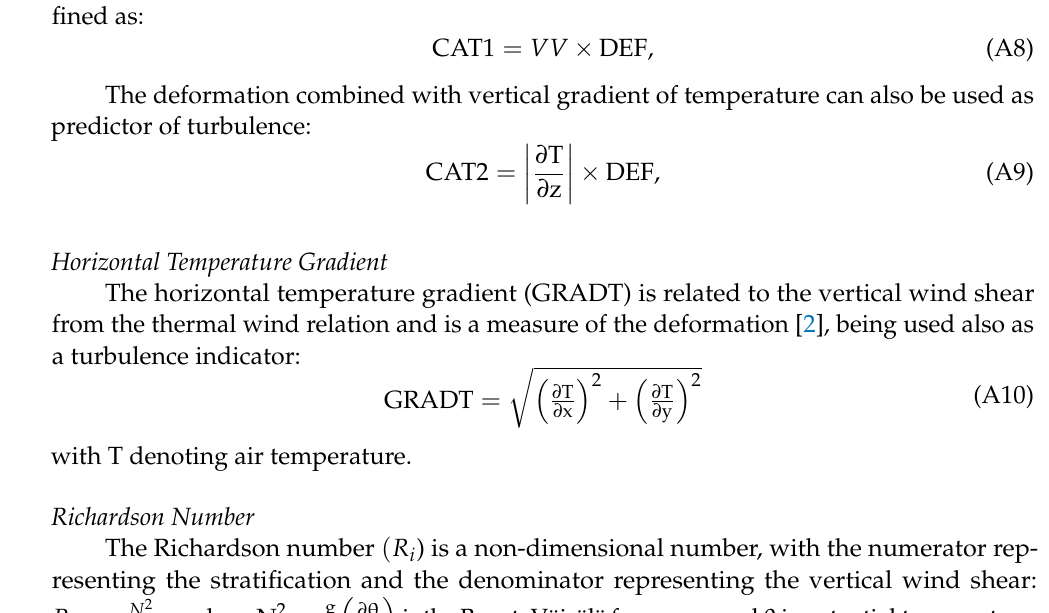
Horizontal Temperature Gradient The horizontal temperature gradient (GRADT) is related to the vertical wind shear from the thermal wind relation and is a measure of the deformation [2], being used also as a turbulence indicator: